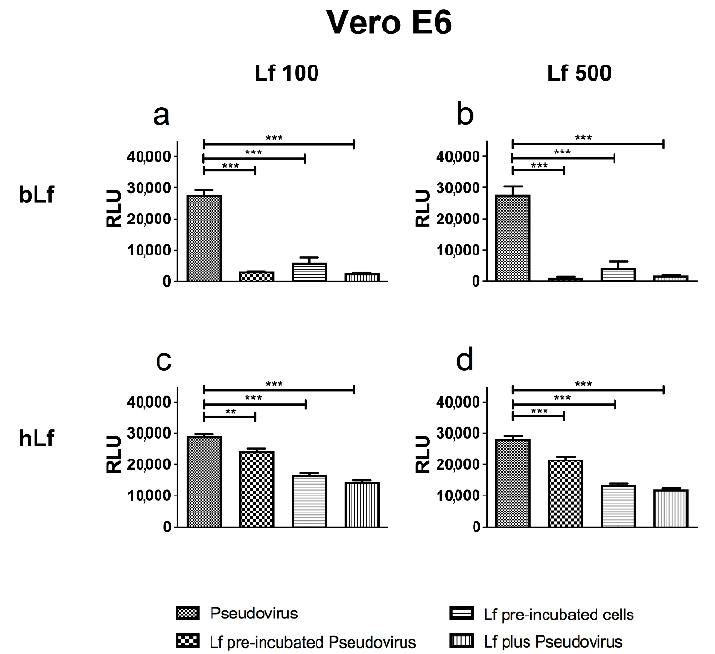
Figure 1. Luminescence of Pseudovirus observed in Vero E6 cells infected at multiplicity of infection (MOI) of 10 in the presence or absence of 1.25 ( a , c ) or 6.25 µ M ( b , d ) of bovine lactoferrin (bLf) ( a , b ) or human lactoferrin (hLf) ( c , d ). See text for details. Data represent the mean values of three independent experiments. Error bars: standard error of the mean. Statistical significance is indicated as follows: **: p < 0.01; ***: p < 0.001 (one-way ANOVA with post-hoc Tukey test). RLU = Relative Luminescence Units.